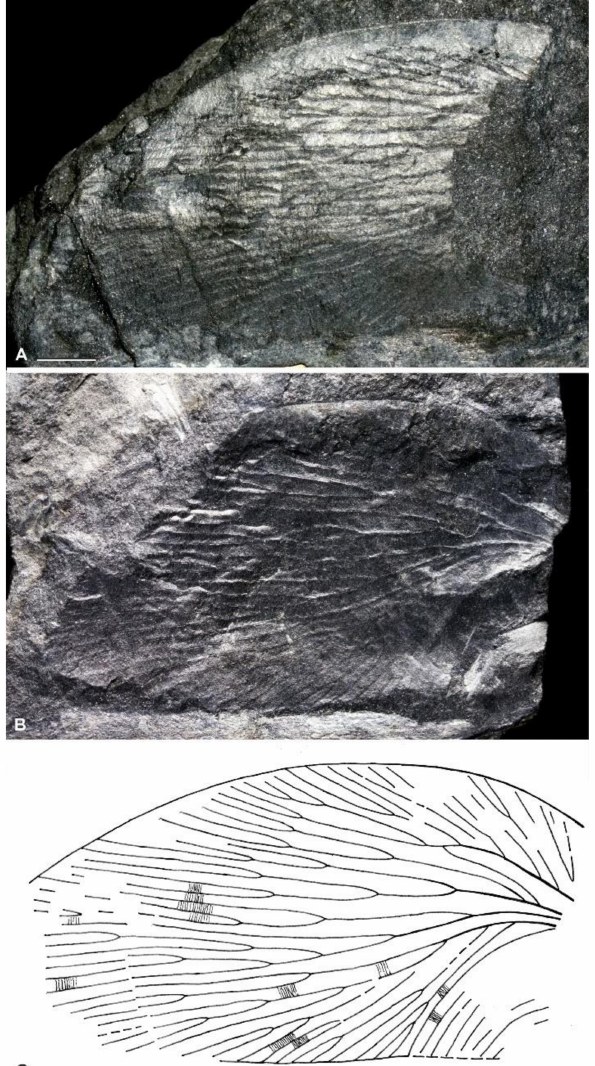
Figure 7. ( A , B )— Progonoblattina clarkii (Scudder, 1893): type specimen of ‘ Etoblattina illustris ’ Scudder, 1893; ( A , B )—part and counterpart, photo: USNM; ( C )—combined drawing; Pawtucket; USNM PAL 38,074 01 and 02; reconstructed length 55 mm; scale bar 5 mm. P. clarkii differs from P. helvetica , described in the following, in the number of branches ending at the wing border, up to 45 in P. clarkii and higher than 50 in P. helvetica , and the bending of the CuA. Middle to late Westphalian forms, as, e.g., the type specimens of the species ‘ E. illustris ’ and ‘ G. scapularis ’, synonymized here with P. clarkii , show strongly sigmoidal M and CuA. The late Westphalian ‘ P. grandis ’, which matches with P. clarkii in the number of branches ending at the wing border (about 49 without An veins), show a nearly straight and inclined CuA that is more typical for P. helvetica . Obviously, there is no clear cut between P. clarkii and P. helvetica ; potential causes are discussed below. Among the unified forms, ‘ Phoberoblatta grandis ’ (Figure 8) and ‘ Cebenniblatta marcellin ’ (Figure 9A,B) represent the slender forewing morphotype of the ovipositor-bearing fe- males among Late Paleozoic blattoids. P. clarkii and ‘ Etoblattina illustris ’ exhibit the stout morphotype of male